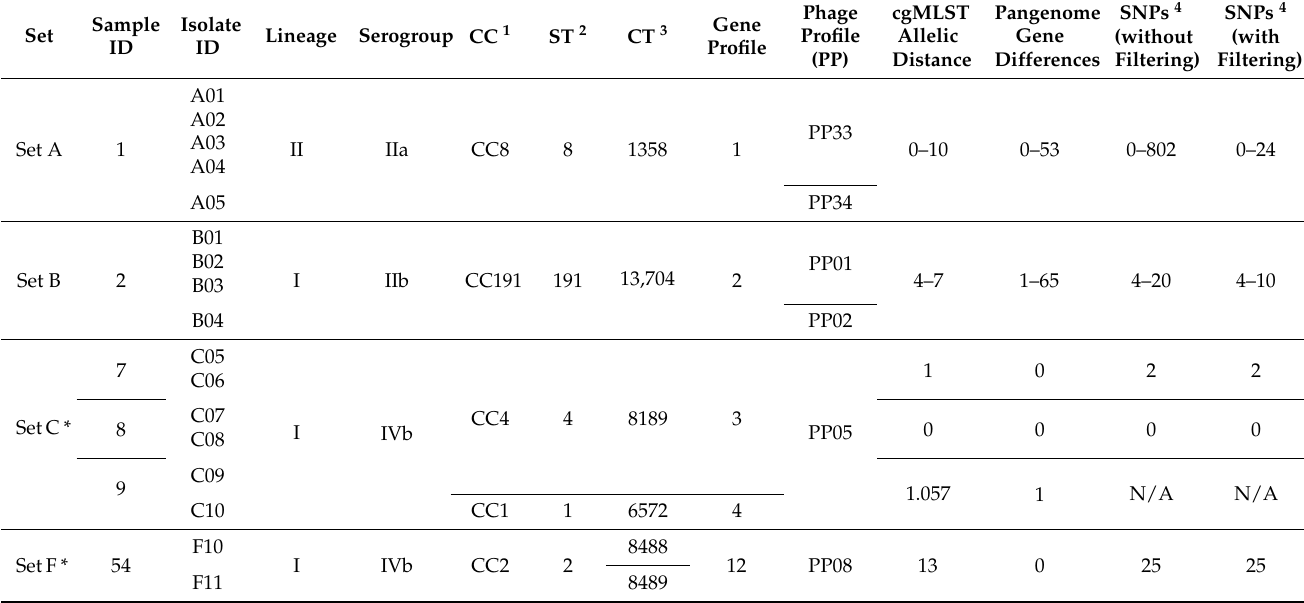
Table 2. Set isolates obtained from the same sample with indication of typing and screening results as well as the number of differences detected between the isolates by different analysis methods. The samples combined within each set had no known link to samples of one of the other sets.